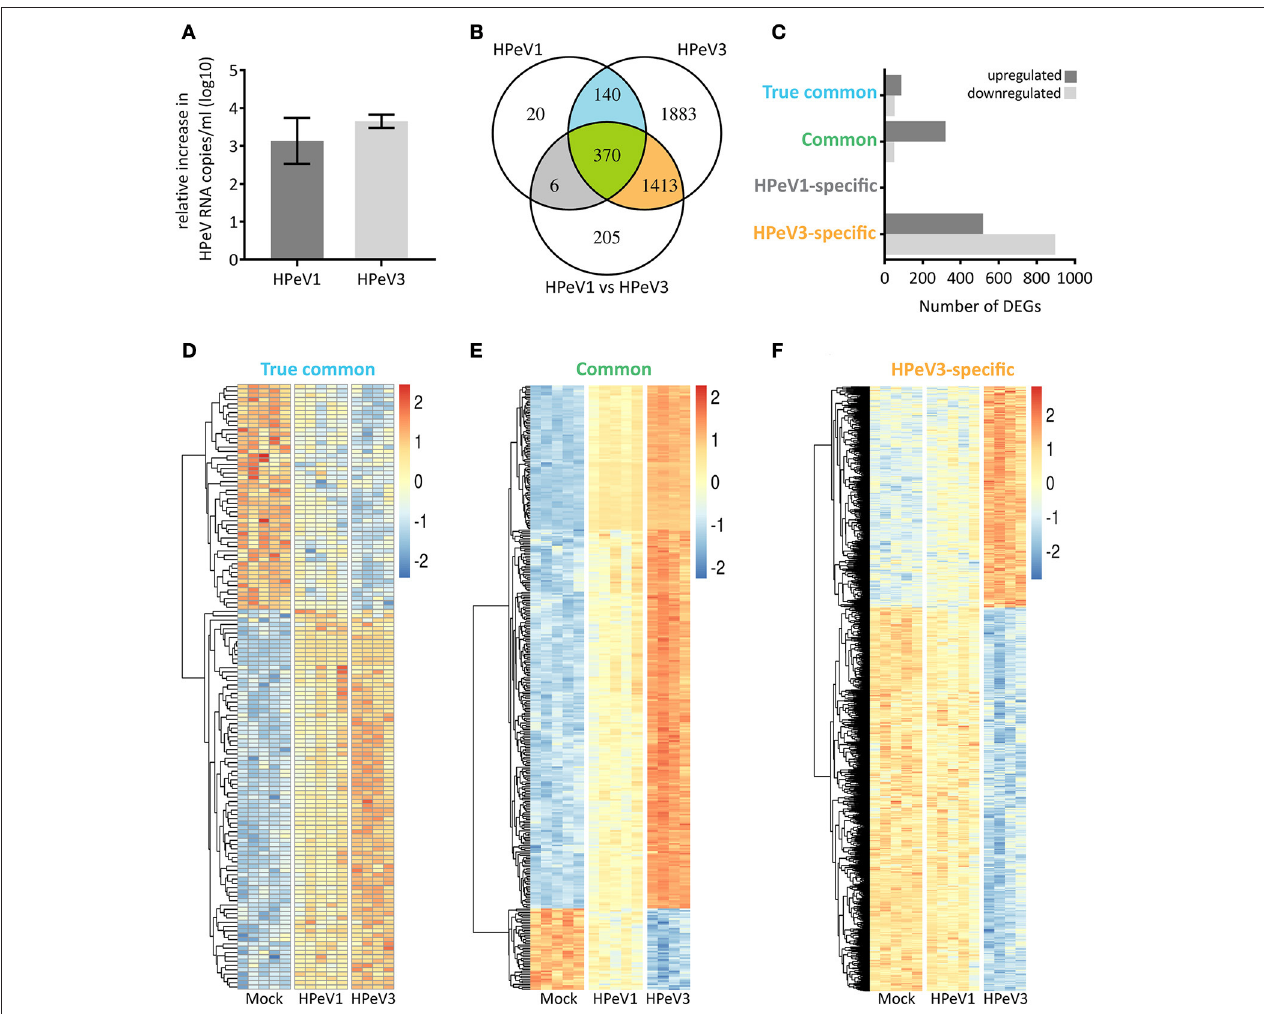
FIGURE 4 | Overview of the significantly differentially expressed genes (DEGs) induced by HPeV infection at day 3 post infection ( p < 0.05, gene expression fold change > 1.2 log2). (A) RT-qPCR analysis of HPeV replication in the HAE apical compartment at the time of microarray sample preparation. (B) Venn diagram showing the total number, overlap and differences in the DEGs induced by HPeV1 and HPeV3. (C) Number of up- and downregulated genes among the four subsets of DEGs; true common, common, HPeV1-specific and HPeV3-specific. (D) Heatmap of the true common DEGs induced similarly by both HPeV1 and HPeV3. (E) Heatmap of the common DEGs induced differently by HPeV1 and HPeV3. (F) Heatmap of the DEGs induced exclusively upon HPeV3 infection. Gene expression fold change scale in the heatmaps is normalized by row